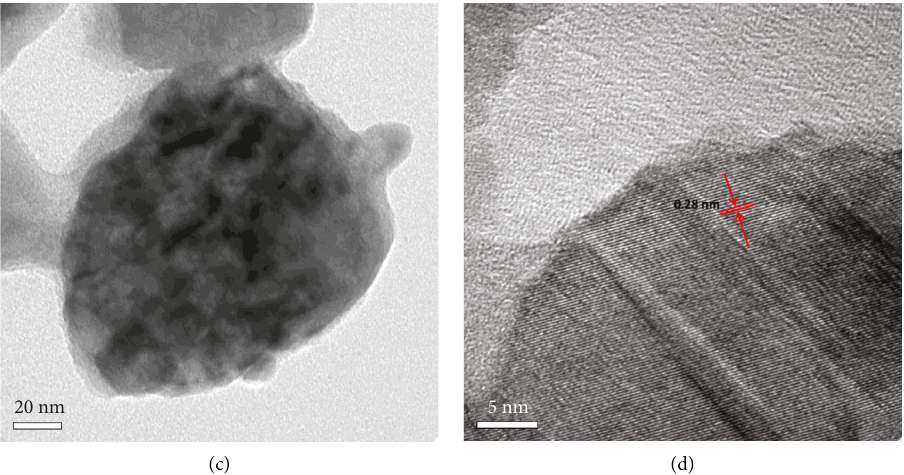
Figure 3: (a–c) TEM image of lower, medium, and higher magnification and (d) HRTEM images of Cu-ZnO (3%) catalyst with plant